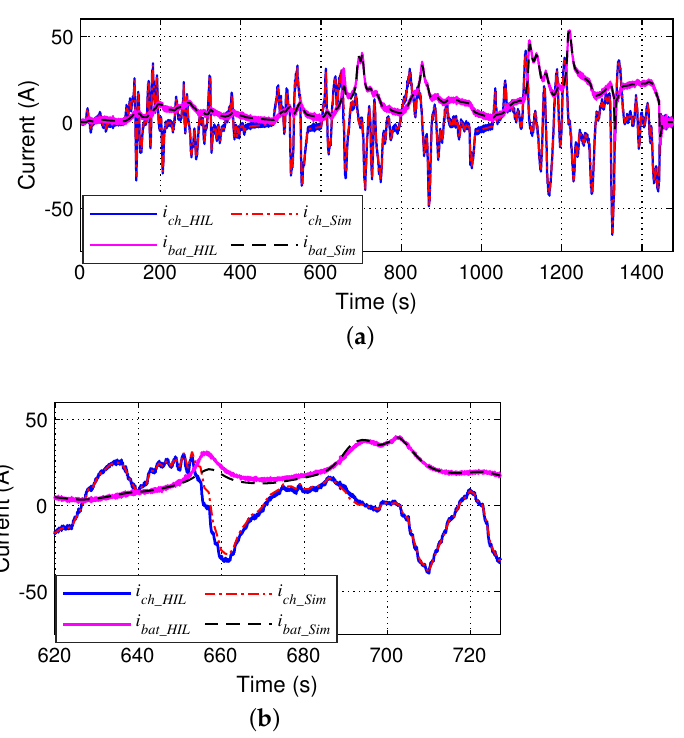
Figure 19. Experimental results of the HESS currents (energy-based strategy): ( a ) Full driving cycle; ( b ) Zoom